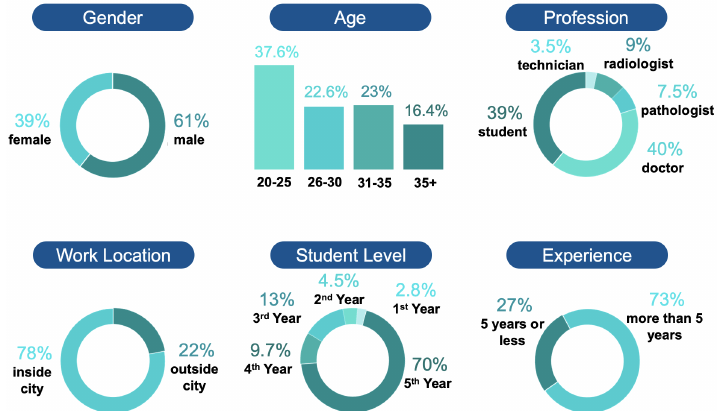
Figure 3. Demographic details of the